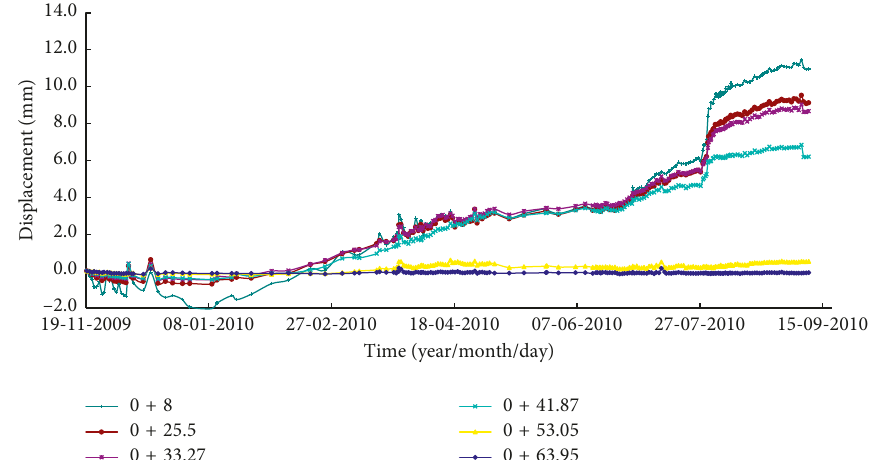
Figure 4: Displacement recorded by the convergence gauge with six points at the exploratory heading PD314 of the right bank slope (the numeral (e.g., 0+8m) represents the distance away from the audit of PD314) [20].